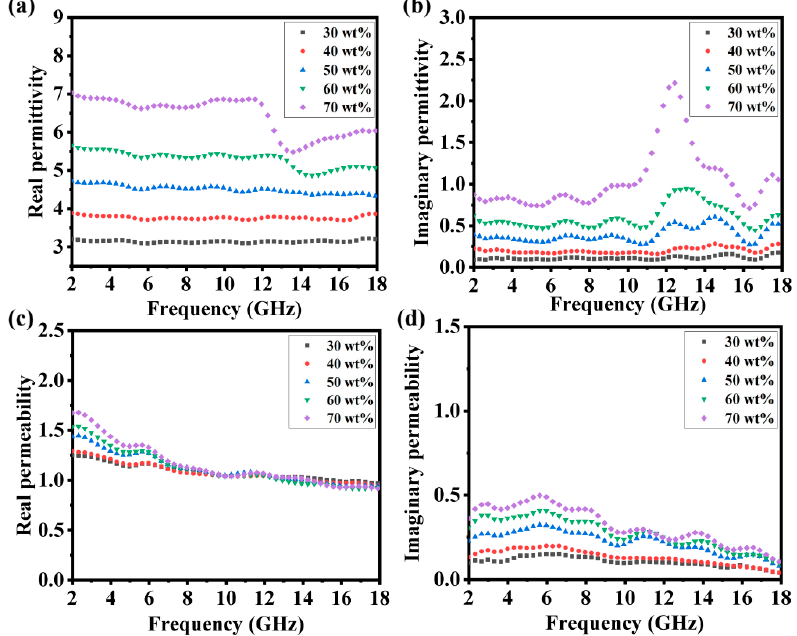
Figure 5. ( a ) The real and ( b ) imaginary parts of the complex permittivity; ( c ) the real and ( d ) imaginary parts of the complex permeability of FeNi 3 samples with different filling ratios.